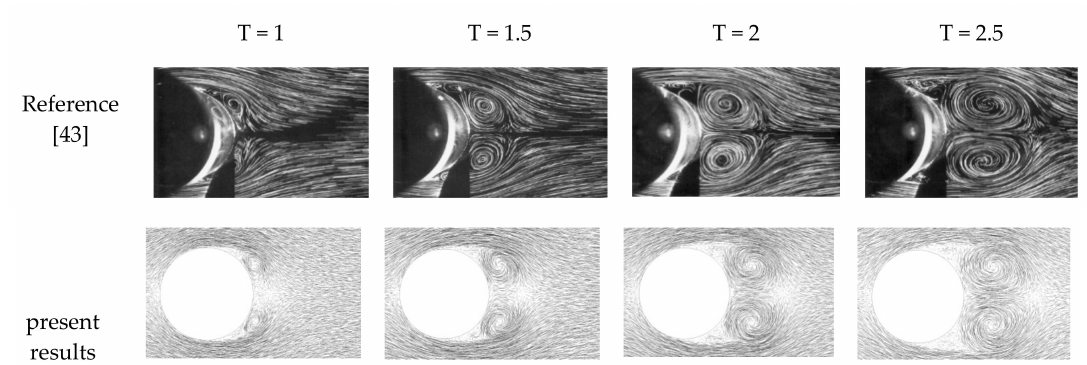
Figure4. ThecomparisonofthewakeflowbetweenthepresentsolutionsandtheresultsofReference[43] for Re =